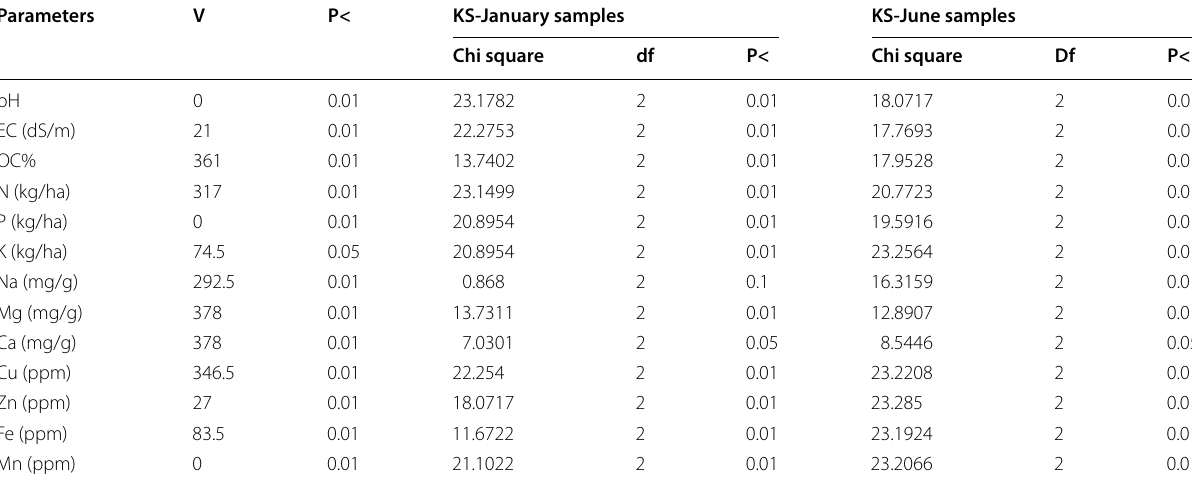
Table 1 Results of the Wilcoxon signed-rank test to examine significant difference in the parameters of the soil sam- ples collected in January and June and Kruskal–Wallis test to examine the significant differences based on locations- upstream, town and